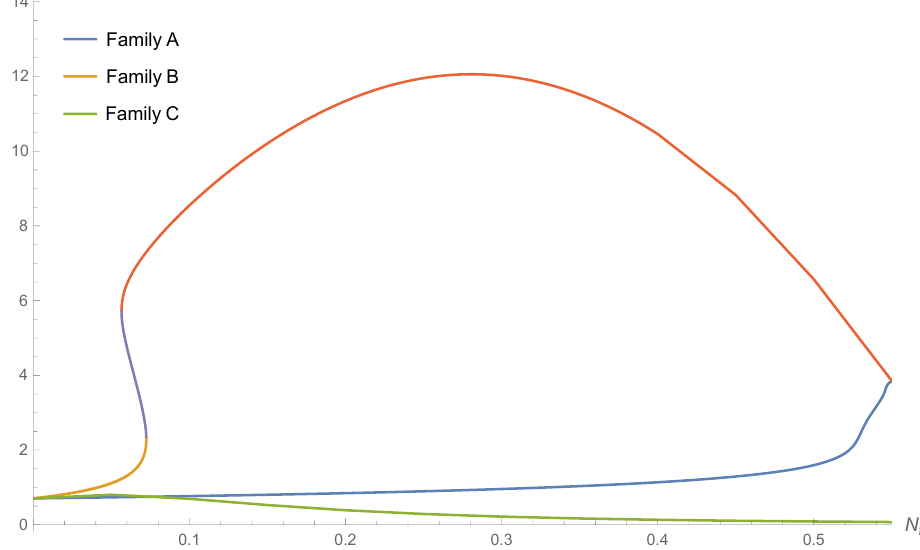
Figure 7. Illustration of the interplay between the NGFPs and the region of instability exemplified in Figure 6 ( β = 0). The figure gives the g ∗ coordinate of various fixed point solutions for values N f below the window